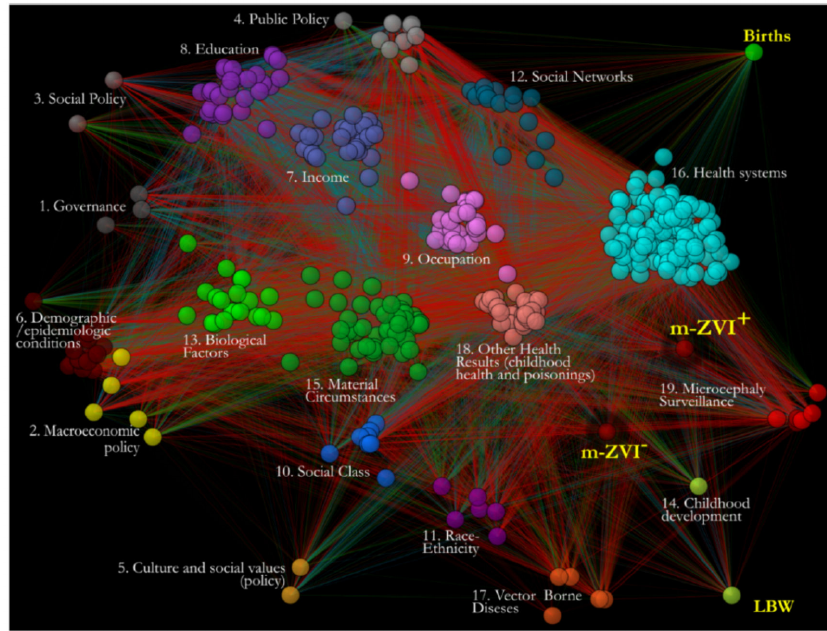
Figure 3. Context networks derived from Public Health Exposome framework and BD2K analytics demonstrates associations of multiple determinant factors with Zika Virus Disease incidence in Brazil’s municipalities during the 2015–2016 outbreak. The full network is shown where four colors show strongest positive partial correlations (dark blue), strong (green), negative strongest (dark red), and strong (light red) partial correlations among variables/nodes. Visualizations include colored nodes according to determinants described in Table 1, and links with colors according to pcor association strength (blue: strongest positive, green: strong positive, red: strong negative, dark red: strongest negative). Fingerprints in different shades of teal correspond to pcor 2 values of direct links with each node/variable and case and control nodes. (darker color bands correspond to stronger links, lighter correspond to weaker links direct links pcor 2 and white corresponds to link absence). Arrows show comparisons between subnetworks as explained in the legend for Figure